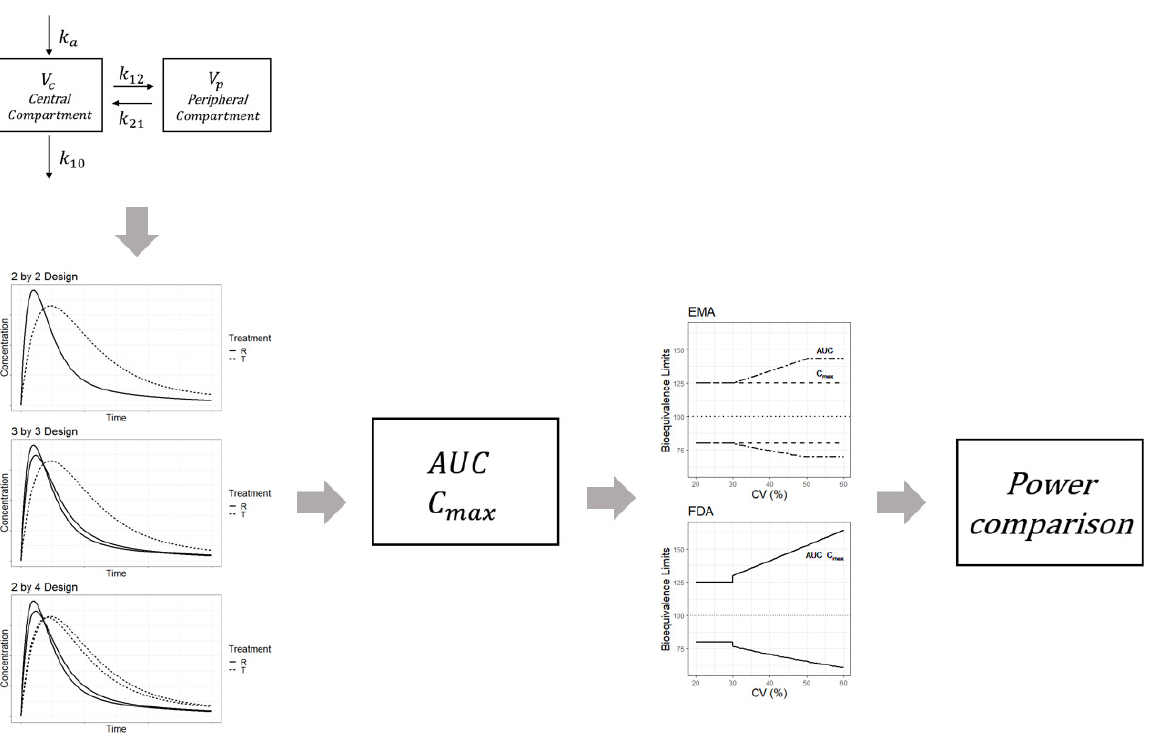
Figure 5. Simulation procedure for the bioequivalence assessment of highly variable drugs based on the pharmacokinetic model.